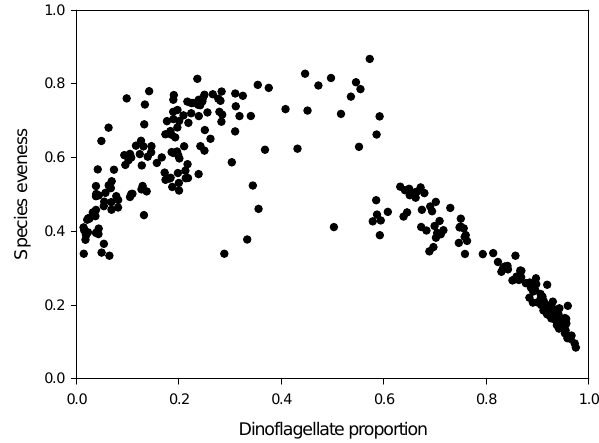
Figure 2. Species evenness plotted against the dinoflagellate pro- portion of the whole community. For later analysis, the phytoplank- ton community was divided into three categories: diatom domi- nance (>80%), mixed community (20–70% dinoflagellates), and dinoflagellate dominance (>70%). The rationale behind setting the group boundaries was based upon the apparent difference in species